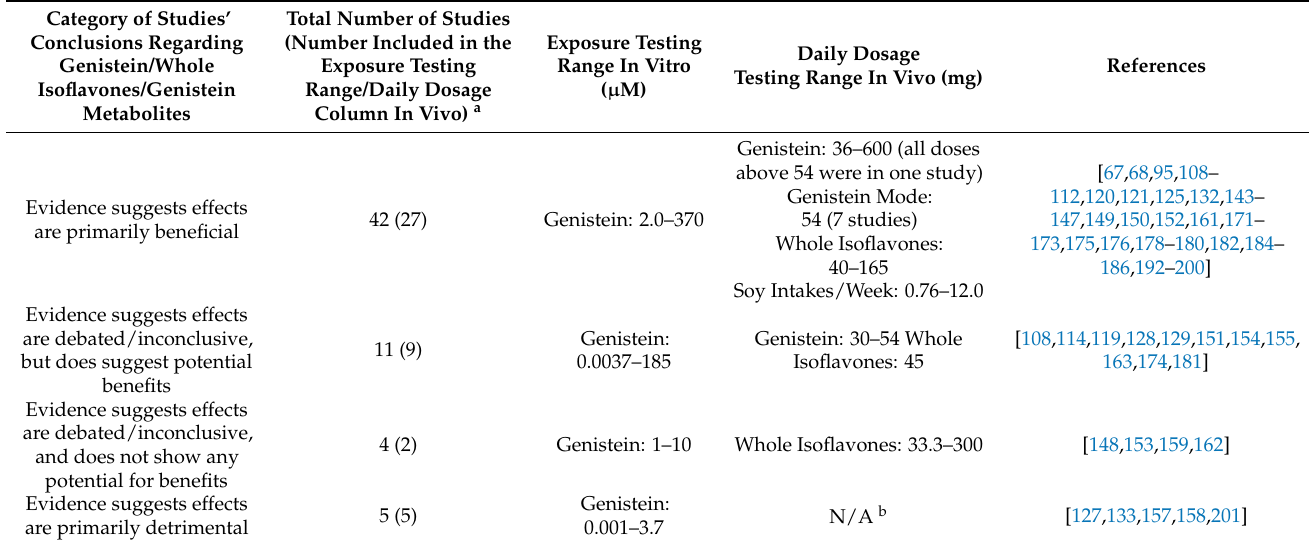
Table 3. Summary of 62 human studies and literature reviews of human studies on genistein’s effects on women’s health—both in vivo and in vitro studies are